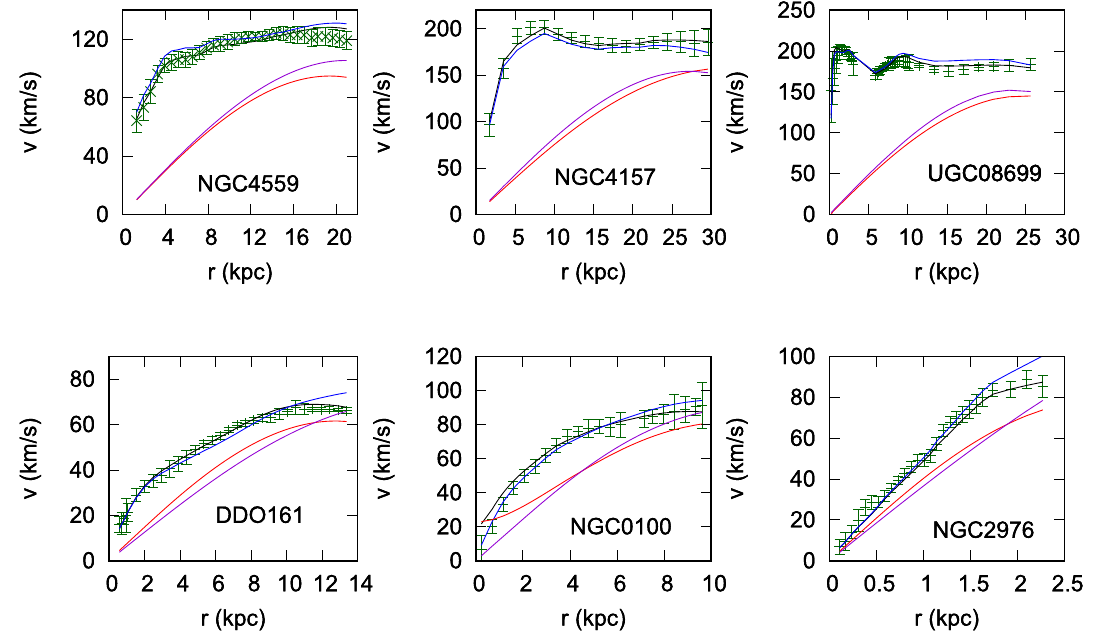
Fig. 15 Comparative analysis of four Bose–Einstein Condensate dark matter models for 6 galaxies. The different theoretical models are rep- resented as follows: RBEC - red curve, RBEC + BM - black curve,